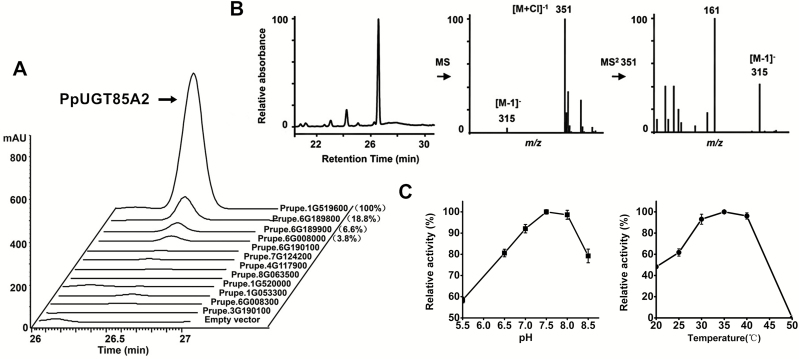
Enzymatic activity analysis of PpUGT85A2 protein. (A) Enzymatic activity of 12 recombinant peach UGT proteins toward linalool as substrate and UDP-glucose as sugar donor. The empty vector (pET6xHN) protein is shown as control. The retention time of linalyl-β-d-glucoside is ~26.5 min. UGT activity of PpUGT85A2 towards linalool is set at 100%. (B) LC/TQMS analysis of linalyl-β-d-glucosides formed by PpUGT85A2. Mass spectra of linalyl-β-d-glucoside consisted of a parent molecule ion [M-H]− with mass/charge (m/z) 315 [315=154 (linalool)+162 (Glc-water)–H]−, and its chlorine adduct m/z 351 [351=315 + 36 (chlorine)]. (C) The optimum pH and temperature for PpUGT85A2 toward linalool and UDP-glucose.